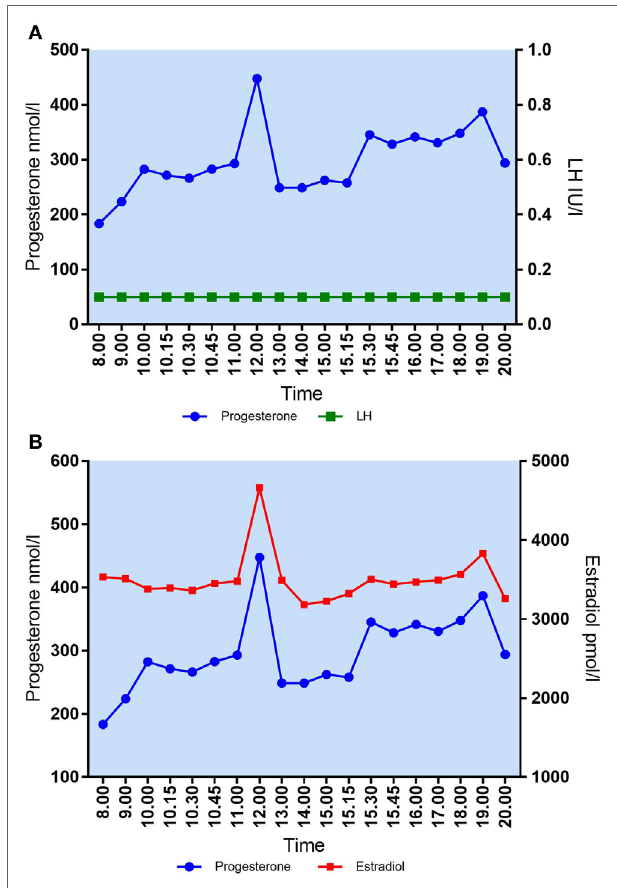
FigUre 2 | (a) Daytime variation in mid-luteal s-progesterone and s-LH in patient #2. Median P 4 = 283 nmol/l. Maximal variation P 4 /12 h = 265 nmol/l. (b) Daytime variation in mid-luteal s-progesterone and s-estradiol in patient #2. Median E 2 = 3,471 pmol/l. Maximal variation E 2 /12 h = 1,481 pmol/l.